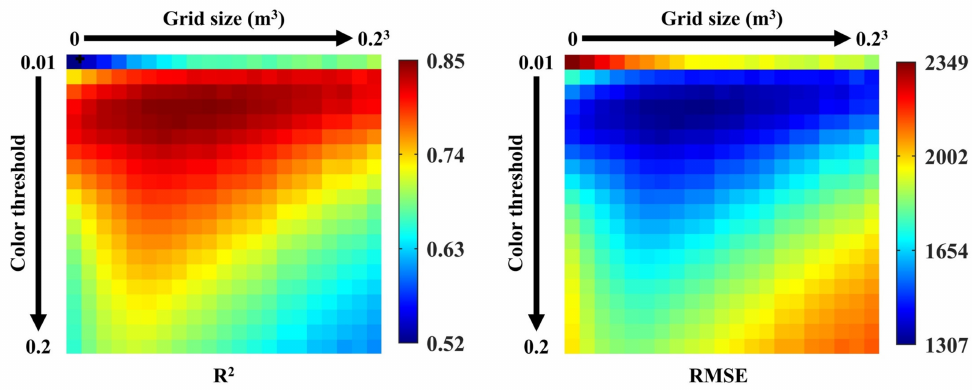
Figure 5. R 2 and RMSE heatmaps of the 420 linear relationships between manual blossom counts and downsampled white blossom point numbers extracted from the 24 cropped tree row section point clouds using different white color thresholds and blossom grid filter